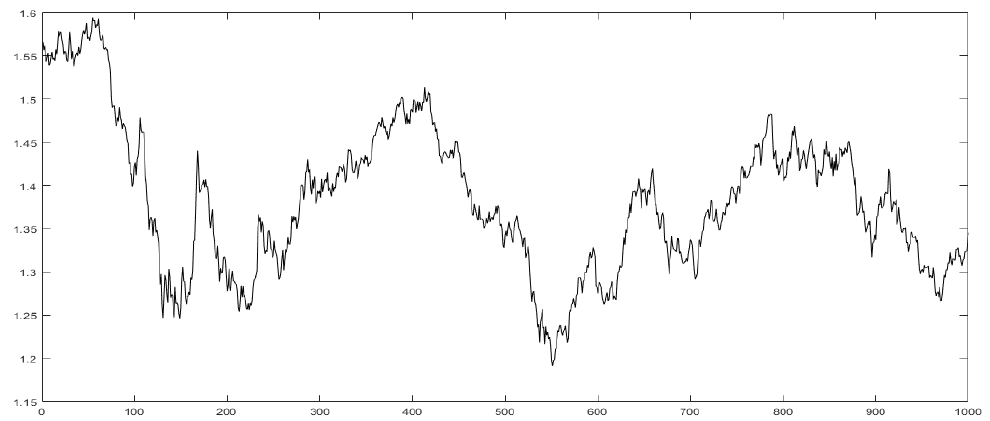
Figure 10. Eruo-Dollar (USA) daily (averaged) exchange rates from 29/04/2008 to